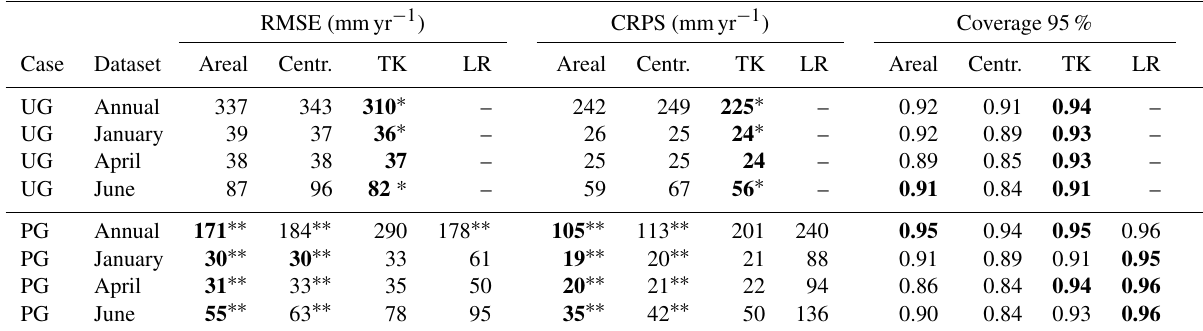
Table 1. Predictive performance for predictions of missing annual values in ungauged catchments (UG) and partially gauged catchments (PG) for the areal model, centroid model, top-kriging (TK) and simple linear regression (LR). The best performance in each row is marked in bold. The RMSE and CRPS were compared across methods by using a one-sided paired Wilcoxon signed-rank test for assessing the significance of the results. Results that were significantly better than other results are marked with stars.